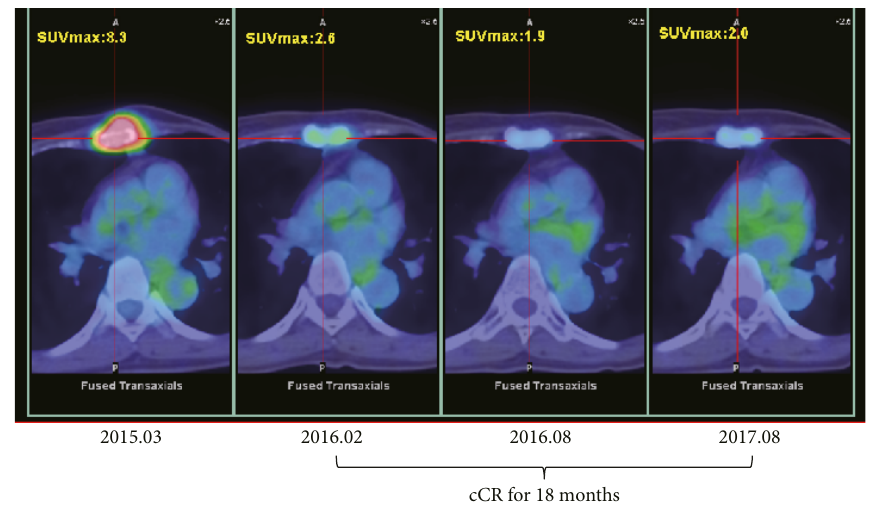
Figure 3: PET-CT of the sternum of Case #17 (assigned as cCR Case 2 ). The cCR status has been maintained for 18 months to